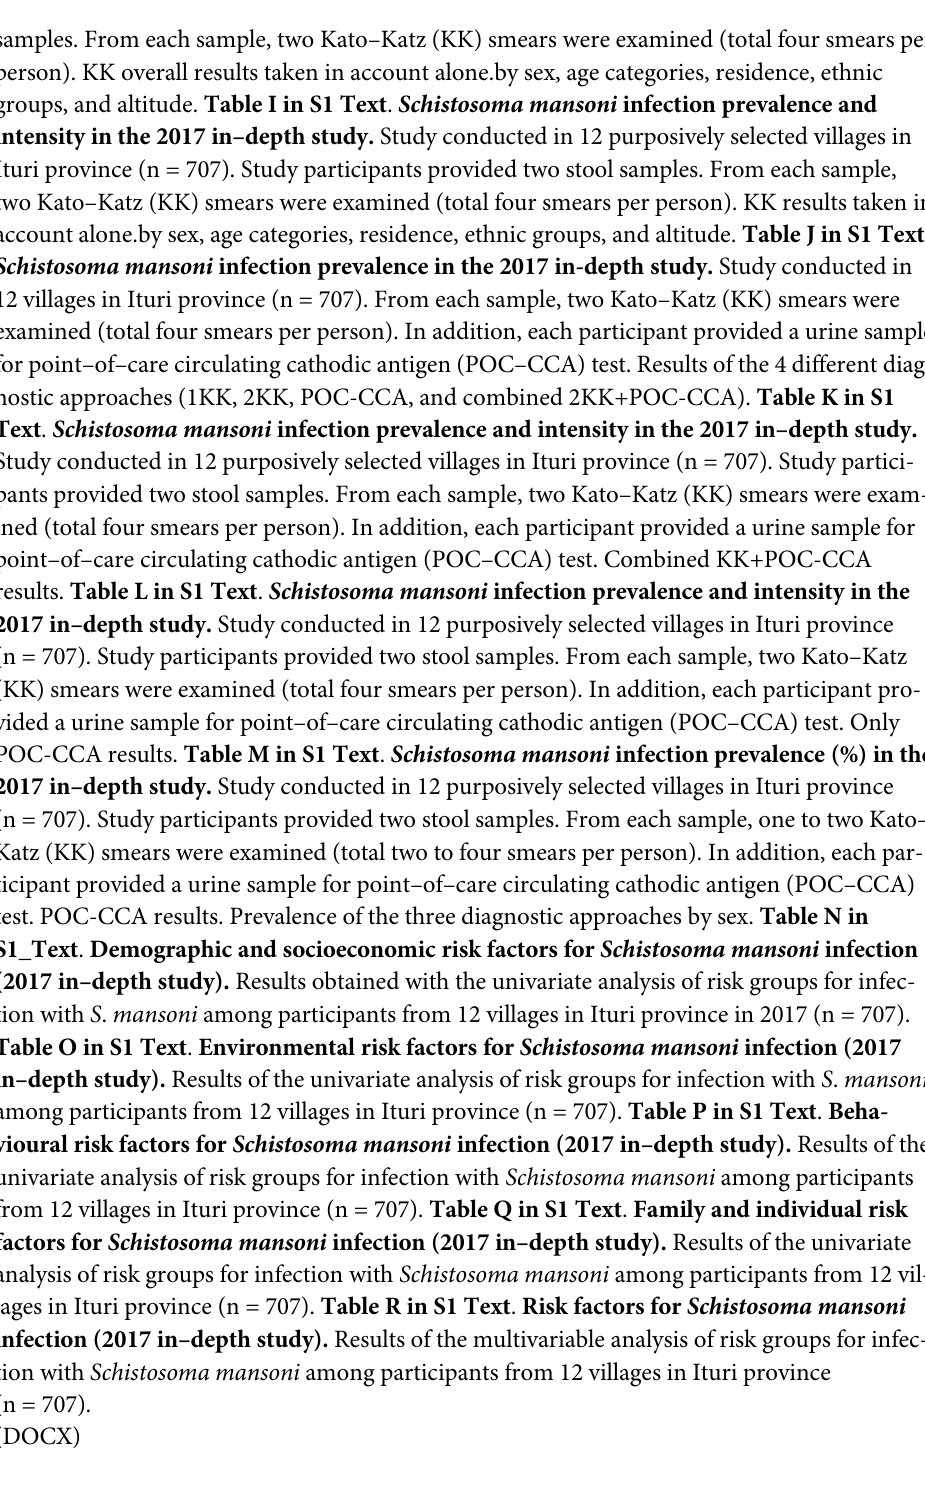
Table O in S1 Text . Environmental risk factors for Schistosoma mansoni infection (2017 in–depth study). Results of the univariate analysis of risk groups for infection with S . mansoni among participants from 12 villages in Ituri province (n = 707). Table P in S1 Text . Beha- vioural risk factors for Schistosoma mansoni infection (2017 in–depth study). Results of the univariate analysis of risk groups for infection with Schistosoma mansoni among participants from 12 villages in Ituri province (n = 707). Table Q in S1 Text . Family and individual risk factors for Schistosoma mansoni infection (2017 in–depth study). Results of the univariate analysis of risk groups for infection with Schistosoma mansoni among participants from 12 vil- lages in Ituri province (n = 707). Table R in S1 Text . Risk factors for Schistosoma mansoni infection (2017 in–depth study). Results of the multivariable analysis of risk groups for infec- tion with Schistosoma mansoni among participants from 12 villages in Ituri province (n =